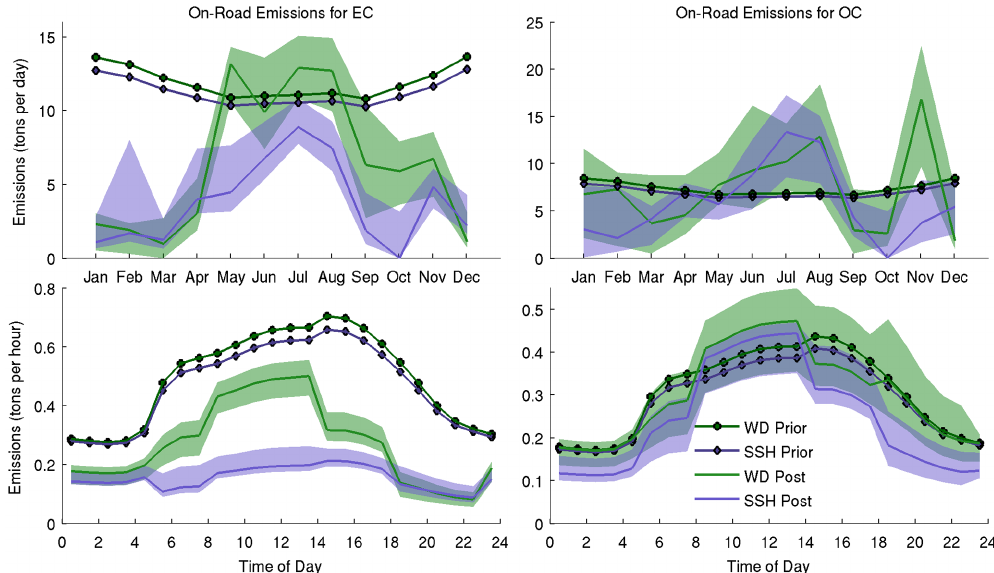
Figure 10. Monthly and diurnal temporal pattern of emissions of EC and OC for on-road emissions by weekday (green, WD) and weekend (blue, SSH) for St. Louis and the surrounding area. LADCO inventory results shown with solid symbols, Inverse model results shown with thin line. Shading shows the 90% confidence interval in the inverse model results based on 100 bootstrapped inversions. Note that OC posterior totals combine primary emissions and secondary formation.